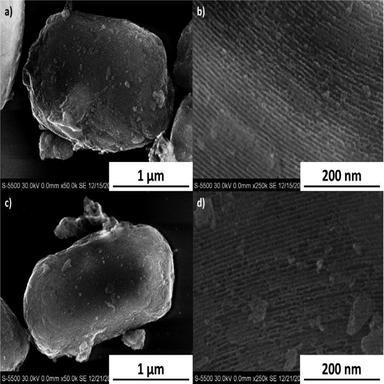
HR-SEM images of S(100)48-PHEMA-30 (a,b) and S(100)48-PHEMA-45 (c,d).